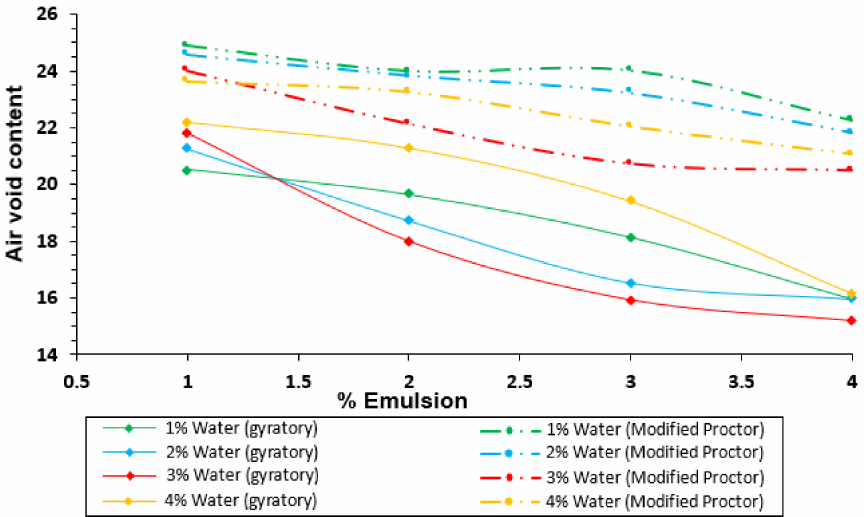
Figure 5. Comparison of air voids content for different premix water contents in samples compacted with the gyratory compactor and the modified Proctor procedure.